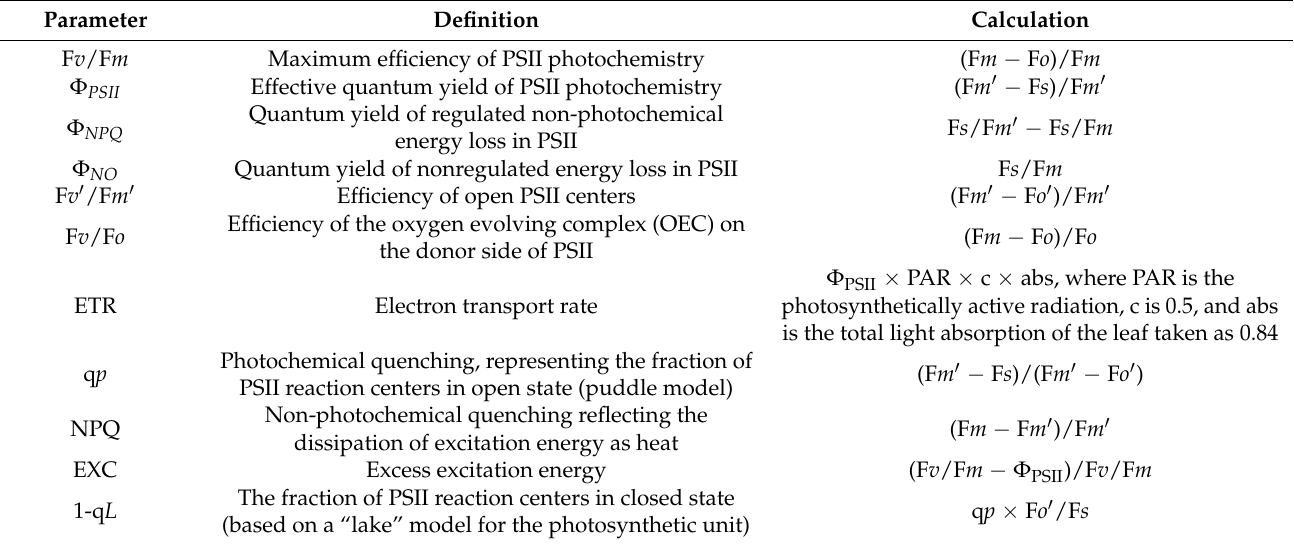
Table 1. The estimated chlorophyll fluorescence parameters with their definitions and their calculation formulae [adopted from